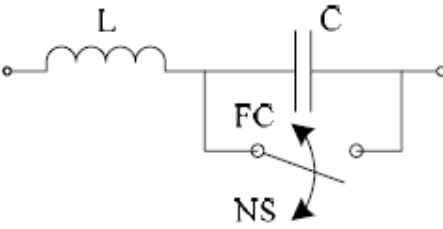
Figure 21. Simple structure of resonant-type FCL.